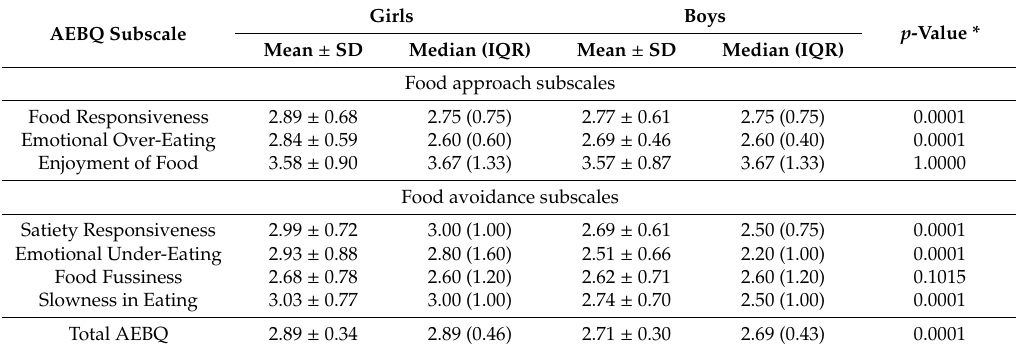
Table 6. The comparison between mean Adult Eating Behavior Questionnaire (AEBQ) subscale scores for Polish girls and boys ( n = 2448).